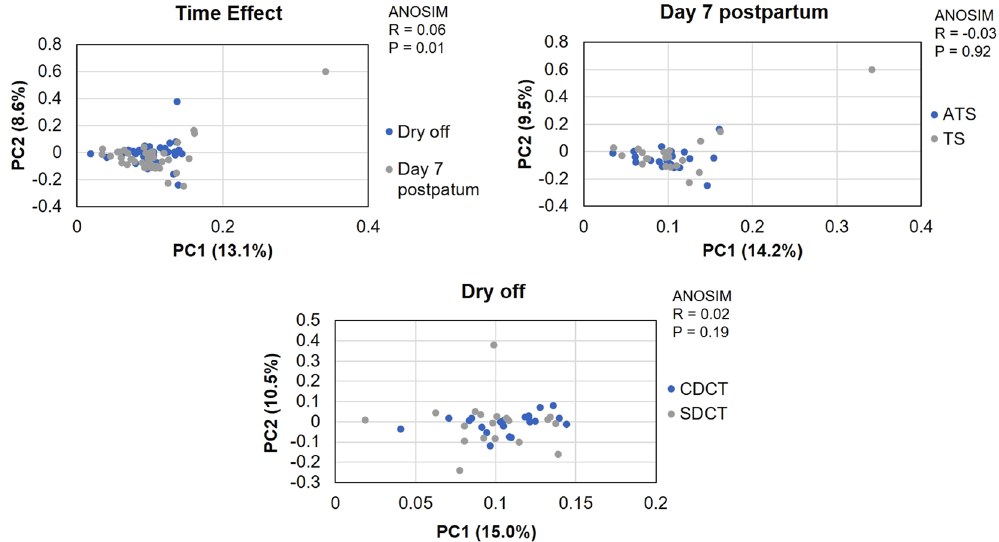
Figure 6. Principal component analysis of weighted Unifrac distances and ANOSIM analysis comparing the microbiome data per time ( A ) of sample collection (dry off and day 7 postpartum) and for conventional dry cow therapy with antibiotic (ceftiofur hydrochloride) and teat sealant (ATS) or selective dry cow therapy receiving only teat sealant (TS) at Dry off ( B ) and 7 days postpartum ( C